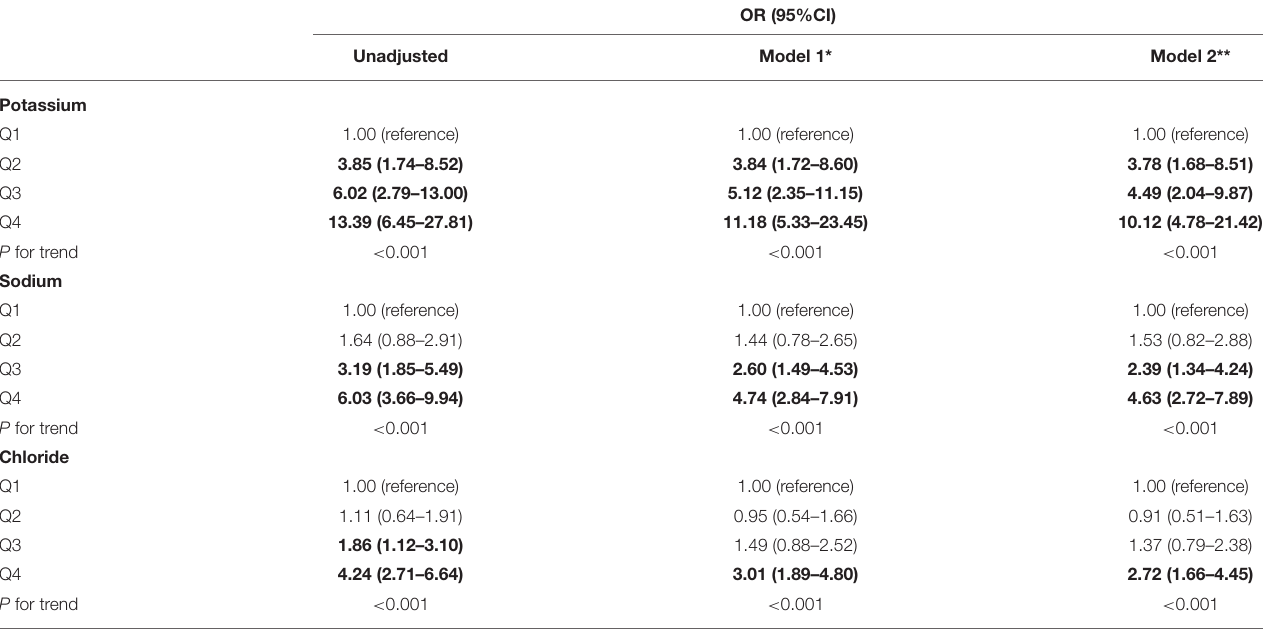
TABLE 2 | Odds ratios and 95% confidence intervals of in-hospital mortality by quartiles of electrolyte variability measured as coefficient of variation.